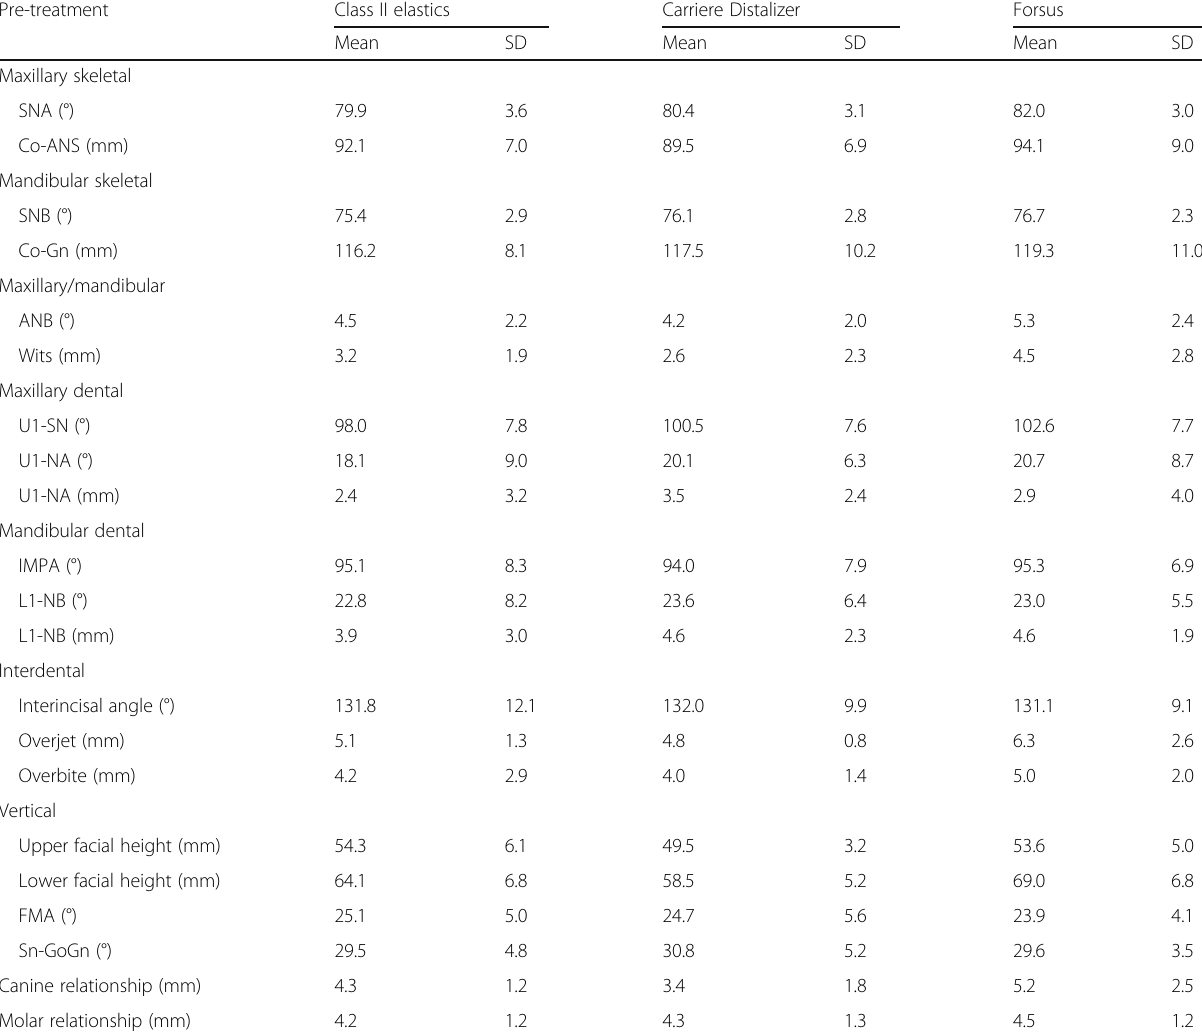
Table 2 Pre-treatment cephalometric measurements and canine/molar relationship